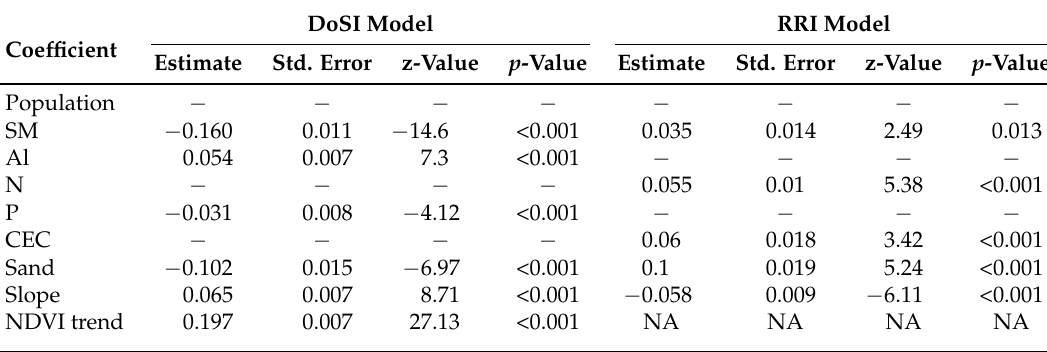
Table 1. Results from the Simultaneous Autoregressive Lag Models (SSALMs). Input values were scaled to make the coefficients comparable. Positive values indicate that an increase in the variable resulted in a higher DoSI or RRI, while negative values indicate the opposite. SM denotes soil moisture. Only coefficients for variables with p < 0.05 are